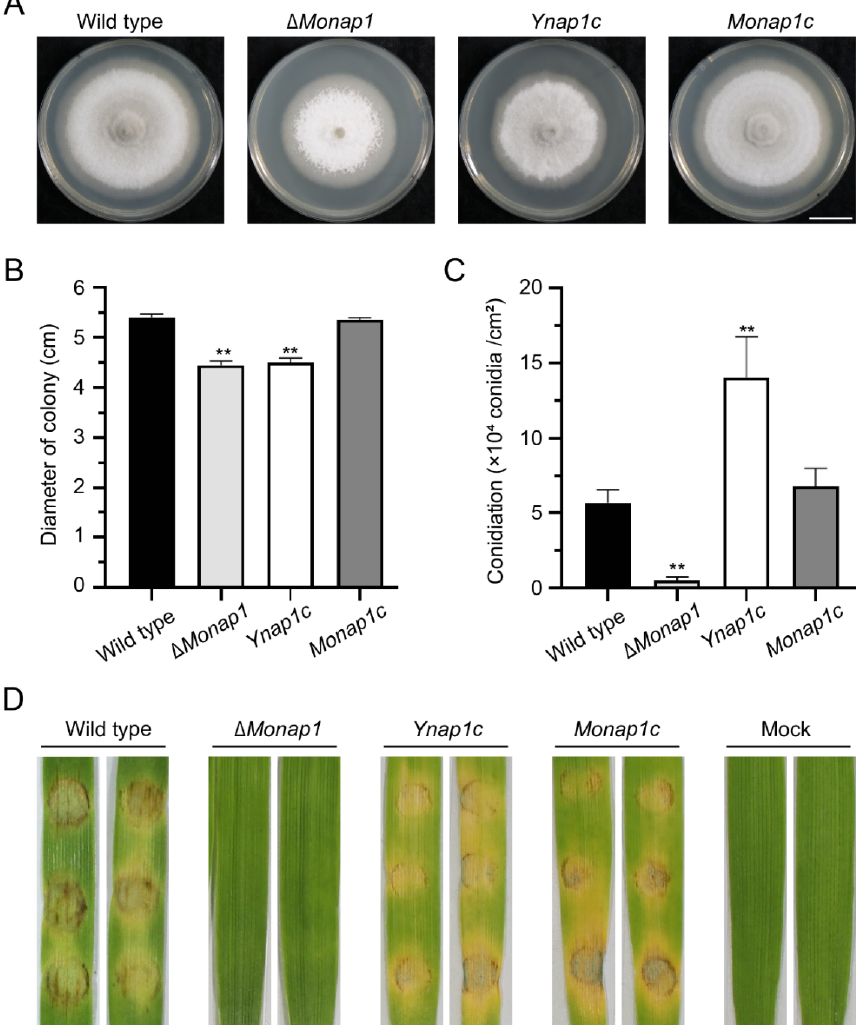
Figure 4. NAP1 in S. cerevisiae can eliminate defects in the sporulation and virulence of Δ Monap1. ( A ) Colonies of the wild type, Δ Monap1 , NAP1 in S. cerevisiae complemented Δ Monap1 strain ( Ynap1c ) and Monap1c strains. Bar, 1 cm. ( B ) Mycelial growth (cm) in the wild type, Δ Monap1 , Ynap1c, and Monap1c strains. n = 5 independent biological replicates. Error bars represent the stand- ard deviations. The data were analyzed by GraphPad Prism 8.0 and significant differences com- pared with the wild type were estimated by multiple t tests: ** p < 0.01. ( C ) Conidiation in the wild type, Δ Monap1 , Ynap1c, and Monap1c strains. At least 150 spores were counted per replicate. n = 3 independent biological replicates. Error bars represent the standard deviations. The data were ana- lyzed by GraphPad Prism 8.0 and significant differences compared with the wild type were esti- mated by multiple t tests: ** p < 0.01. ( D ) Disease symptoms on leaf explants of barley inoculated with mycelial plugs from wild type, ∆ Monap1 , Ynap1c , and Monap1c . The pictures were photo- graphed at 4 dpi.